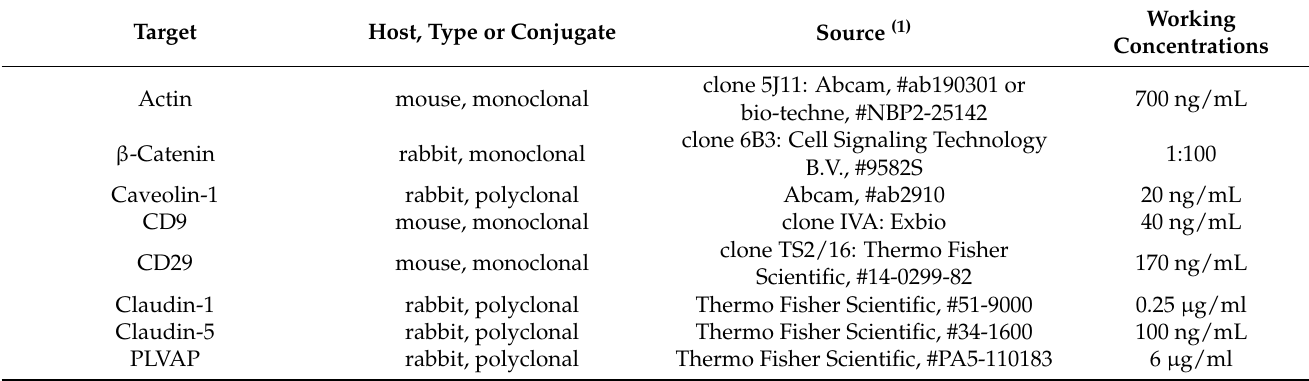
Table 2. Primary and secondary